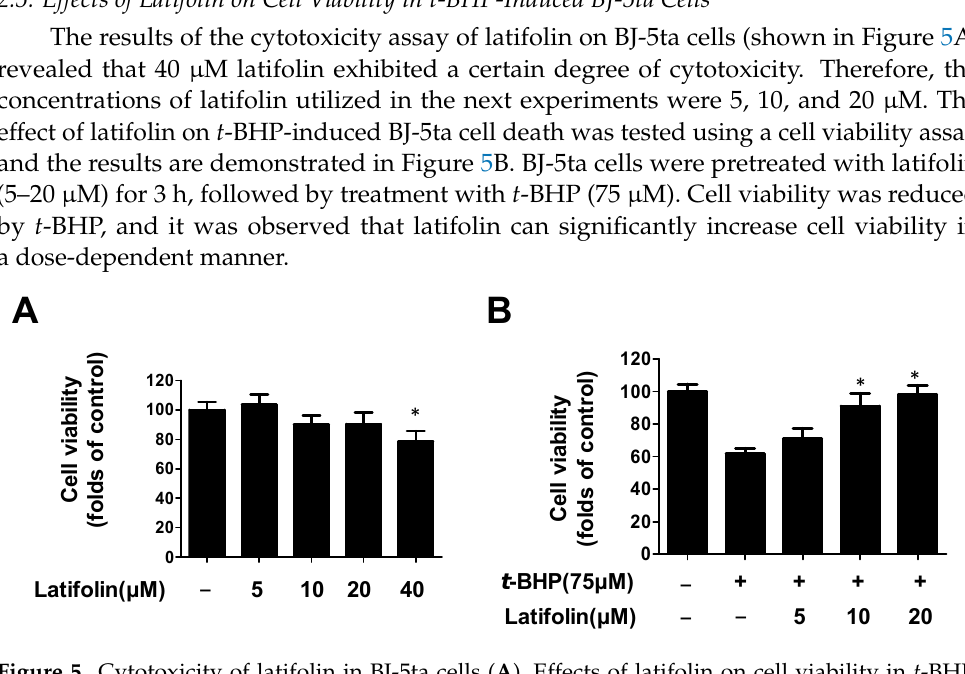
Figure 5. Cytotoxicity of latifolin in BJ-5ta cells ( A ). E ff ects of latifolin on cell viability in t -BHP- induced BJ-5ta cells ( B ). The data are presented as the mean ± SD ( n = 3). * p < 0.05 vs. t -BHP group. 2.6. Effects of Latifolin on ROS Production Induced by t-BHP in BJ-5ta Cells various skin diseases [24]. Antioxidants are essential for inhibition of oxidative damage and protection of skin; therefore, we measured the effect of latifolin on t -BHP-induced intracellular ROS accumulation using t -BHP in BJ-5ta cells. Fluorescence microscopy images indicated that latifolin inhibited t -BHP-induced ROS production in BJ-5ta cells (Figure 6); both 10 and 20 µ M latifolin exhibited this ROS inhibition effect.